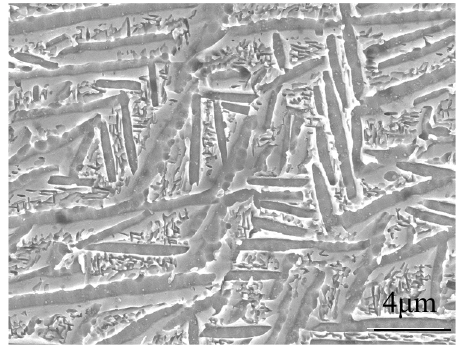
Figure 1. Microstructure of the as-received Ti-17 alloy.